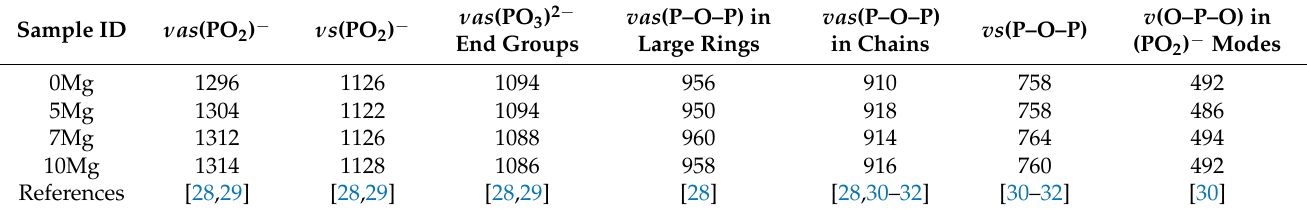
Figure 2. XRD curves for all as-quenched samples.